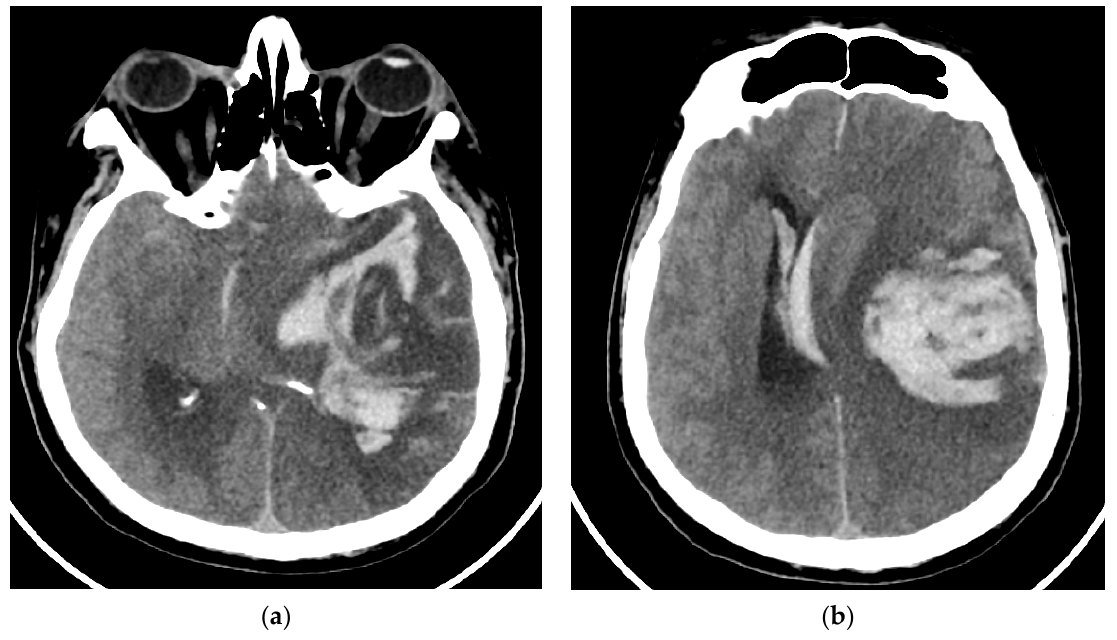
Figure 4. ( a , b ), Brain-CT showed acute hemorrhage of intraparenchymal fronto-parieto-temporal lobes with important edema and ventricular extension.